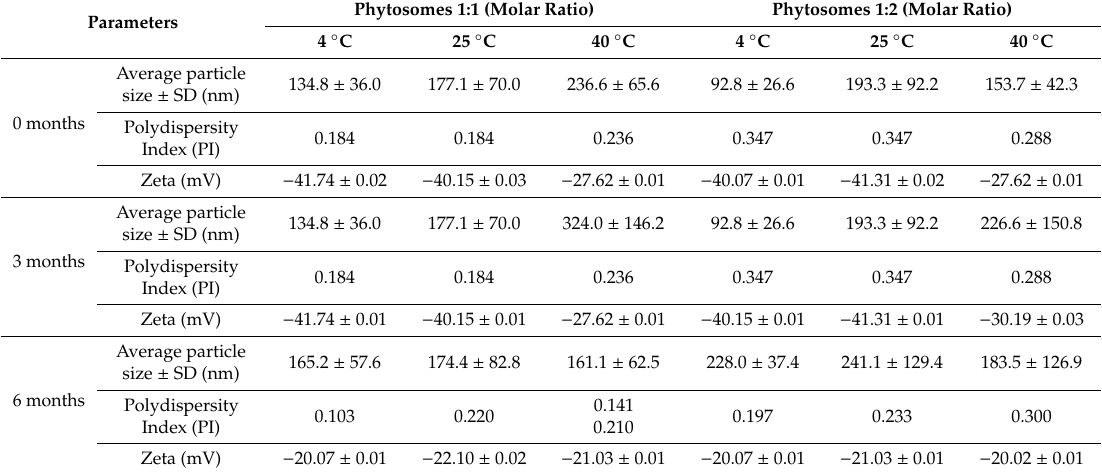
Table 4. The characterization of the